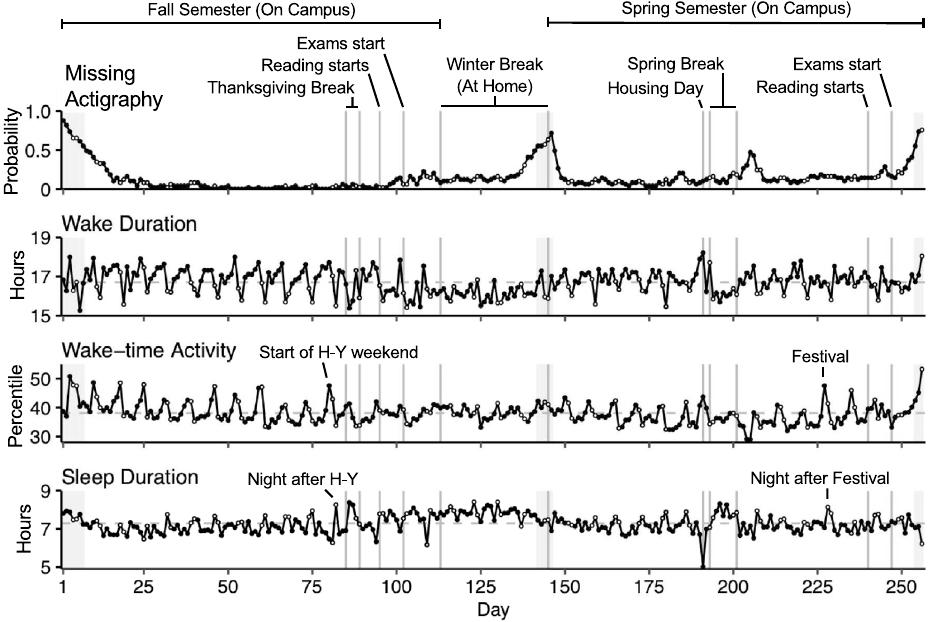
Figure 1. Activity and sleep patterns show school break and weekly fluctuations. Time series show daily actigraphy-derived observations averaged across the full sample. Vertical lines indicate landmark events in the academic calendar, labeled at the top. Black circles indicate Monday through Friday and white circles indicate Saturday and Sunday (sleep observations correspond to the day when the participant woke up). Dashed gray lines indicate the mean. The top panel shows the probability that survey-based observation is missing on any given day (i.e., the proportion of missing individual observations out of the total sample), and the gray shading across panels indicates days with more than 50% missing observations. H-Y Harvard-Yale football game, Festival music festival hosted on